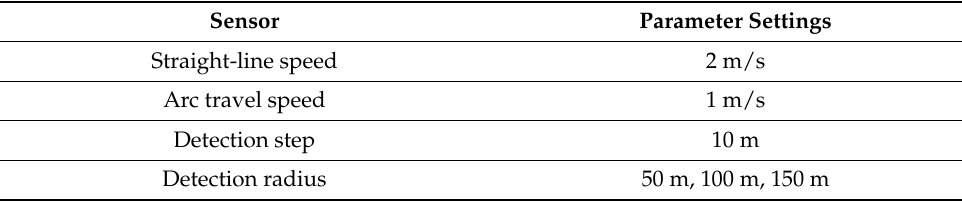
Table 1. Sensor parameter